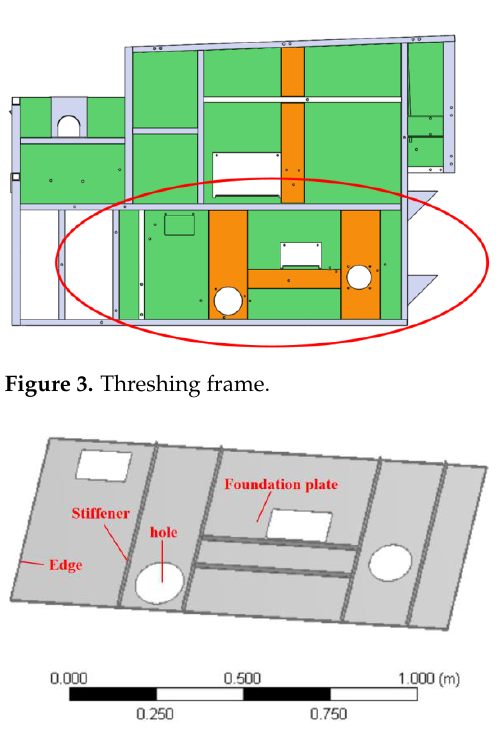
Figure 4. Plates of combine harvesters.